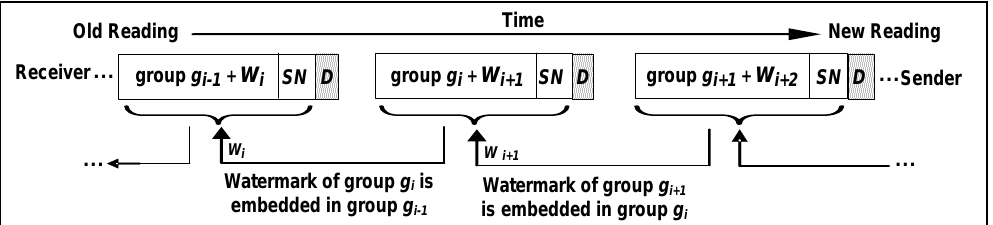
Figure 1. Forward-chaining Watermark Embedding Process (Default).